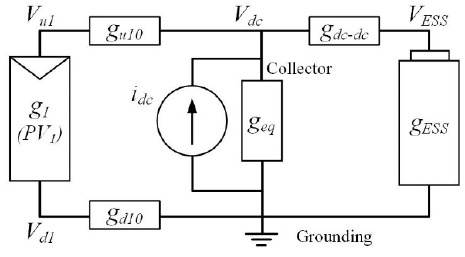
Figure 5. Power flow analysis model for DC.